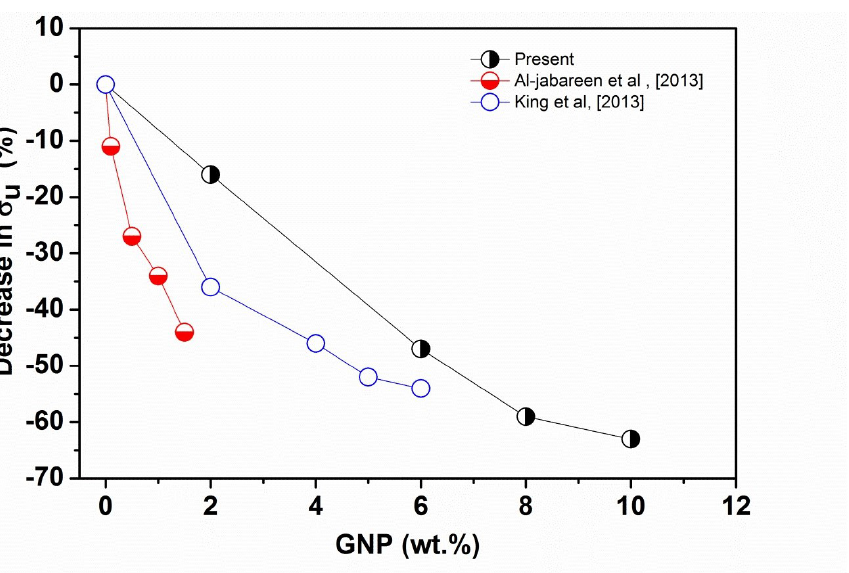
Figure 3. A comparison of σ u data from Al-Jabareen et al. [32] (PET matrix) and King et al. [33] (Epoxy matrix) with the present experimental